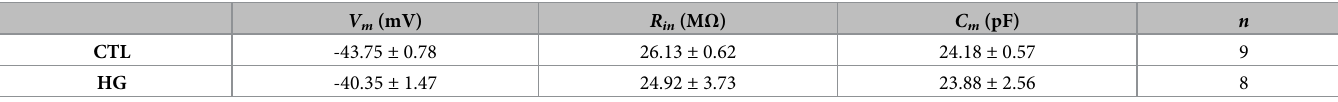
), input resistance ( R ), and cell m in